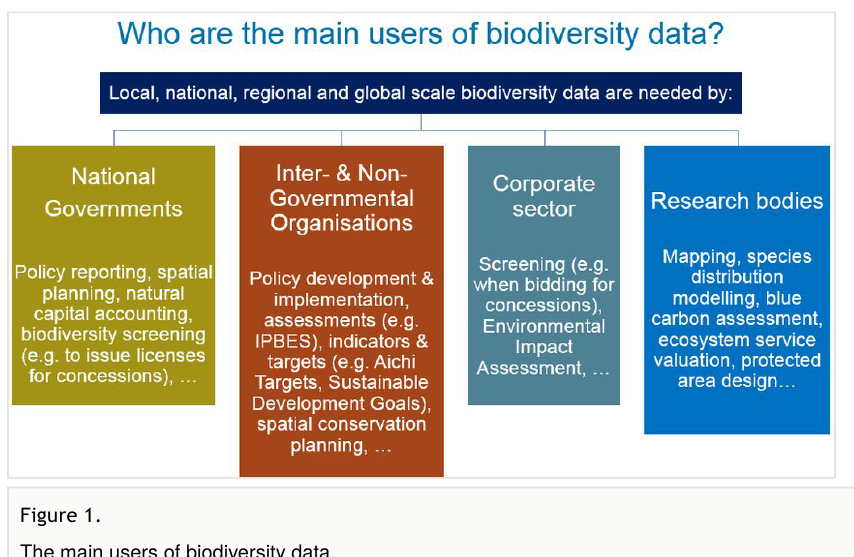
Figure 1. The main users of biodiversity